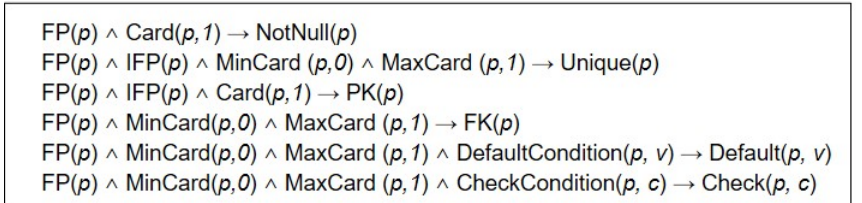
Figure 7. Simple mapping rules of integrity constraints.